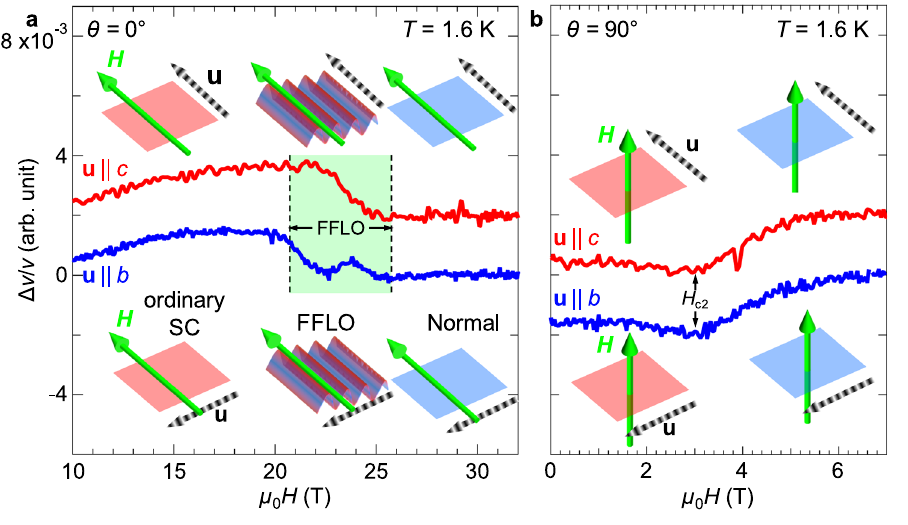
Fig. 4 | Emergent anisotropy in the FFLO state. a , b Δ v / v at 1.6K for u || b (blue) and u || c (red)inmagnetic fi elds a parallel( θ =0°)and b perpendicular( θ =90°)to the 2D conducting plane. Direction dependence of the longitudinal sound wave propagation isobserved only in the FFLO state (green area), whereas the direction